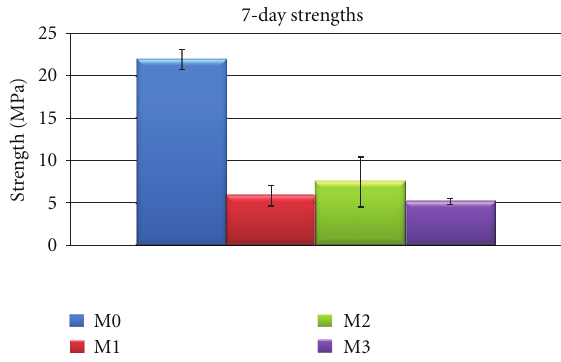
Figure 4: 7-day compressive